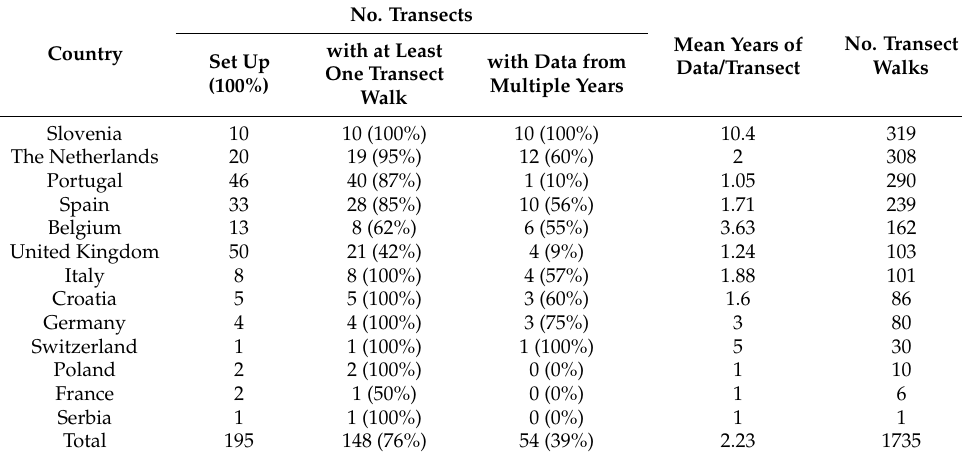
Table 1. Countries with the number of transects and transect walks ordered by number of transect walks. Percentage comparing numbers to total number of transects set up. For transects with multiple years, percentage is calculated by excluding the transects set up in 2020 because they do not yet have data from multiple